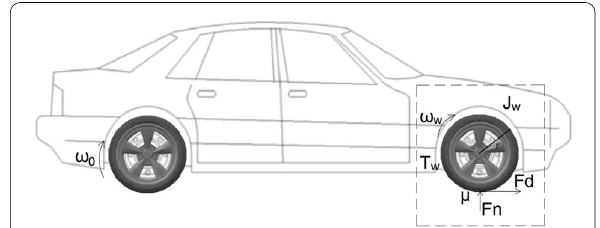
Figure 3 The wheel